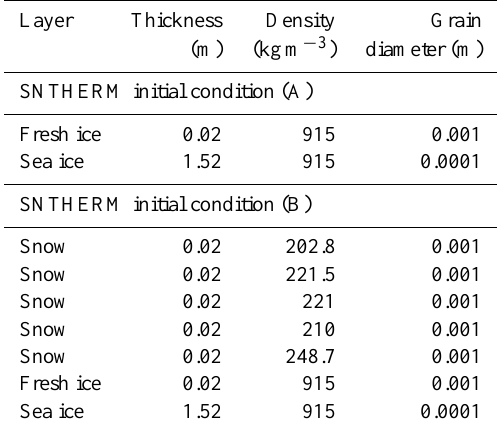
Table 2. Initial conditions for cases A and B. Note small artifi- cial grain sizes input for sea ice. These values were also tested at 0.001m and did not affect the results of the